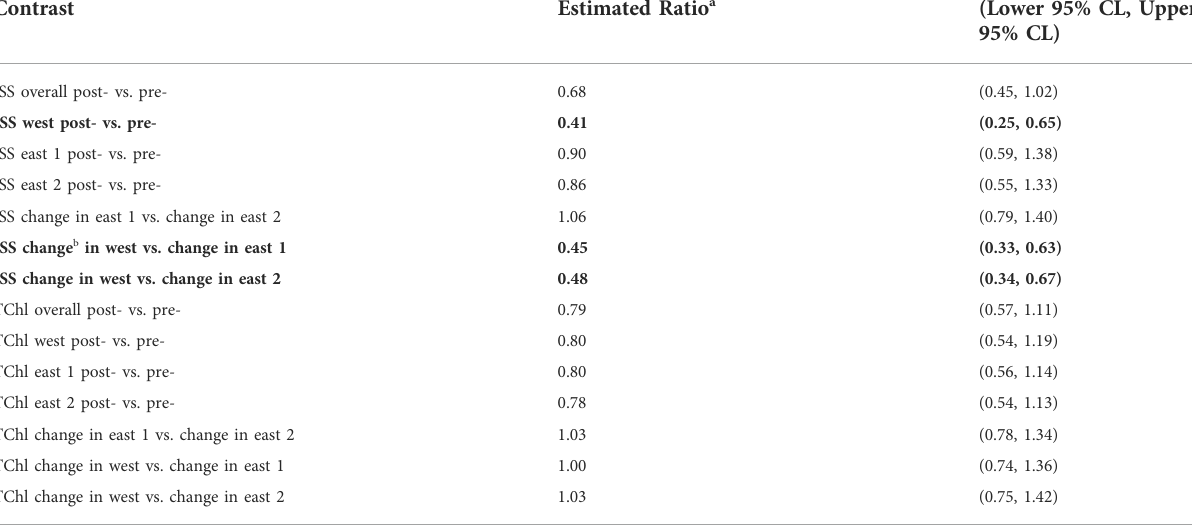
TABLE 1 Tests of contrasts in inorganic suspended solids (ISS) and total chlorophyll (TChl) within the carp exclusion zone during May to July by treatmentperiod[pre-(2009,2010,and2012)andpost-(2013 – 2018)carpexclusion]andmarshunit(west,east1,east2),DeltaMarsh,Manitoba. Contrasts are statistically signi fi cant (bold) when 95% con fi dence intervals exclude 1.00 (CL = con fi dence